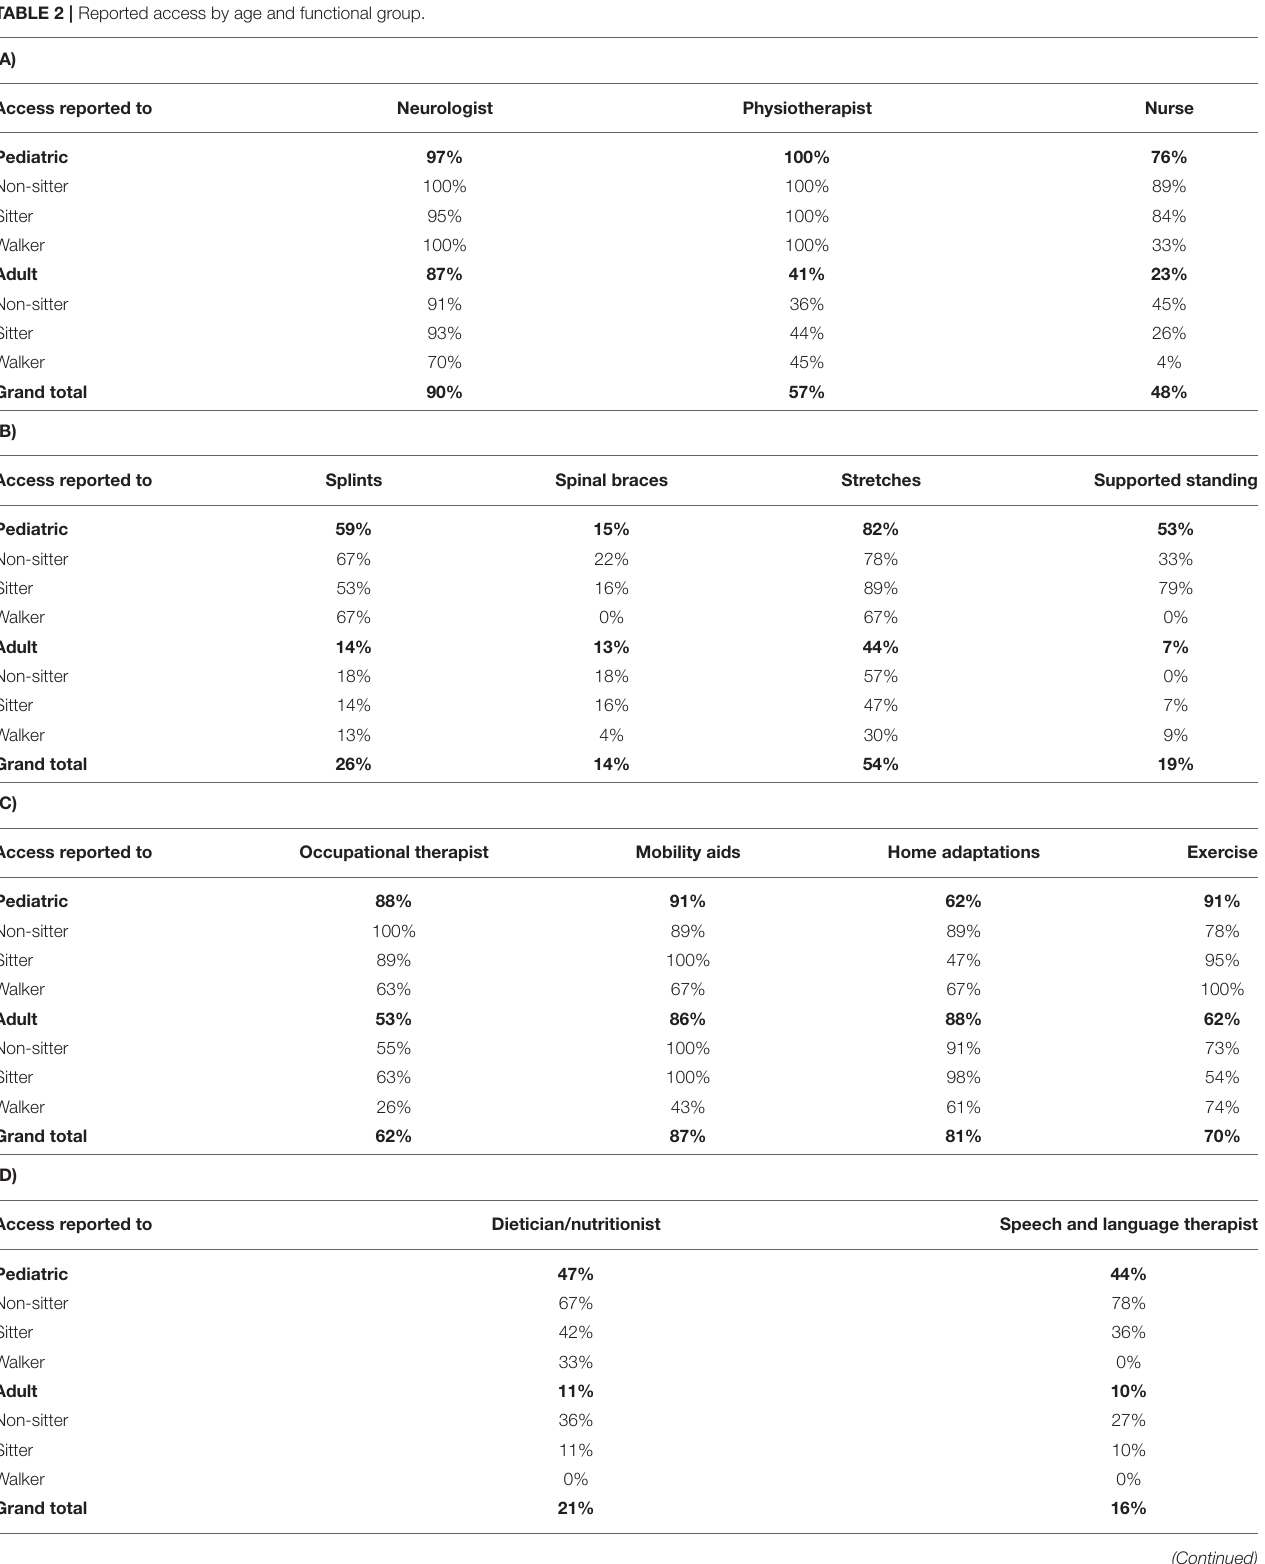
TABLE 2 | Reported access by age and functional group. (A) Access reported to Neurologist Physiotherapist Nurse Pediatric Non-sitter